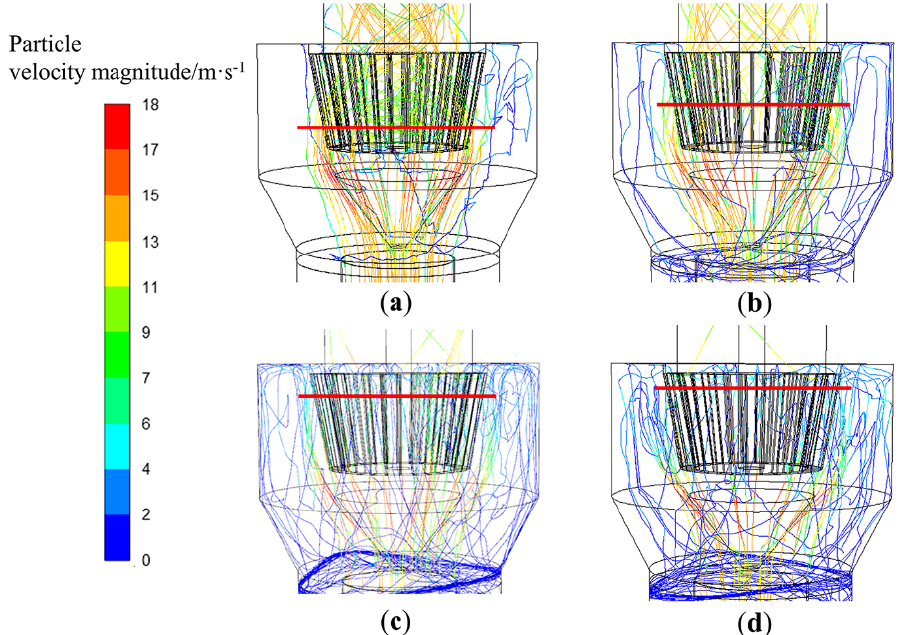
Figure 10. Trajectories of different size particles in T-C (1-0.8) : ( a ) d = 5 μ m, ( b ) d = 15 μ m, ( c ) d = 25 μ m, and ( d ) d = 35 μ m.